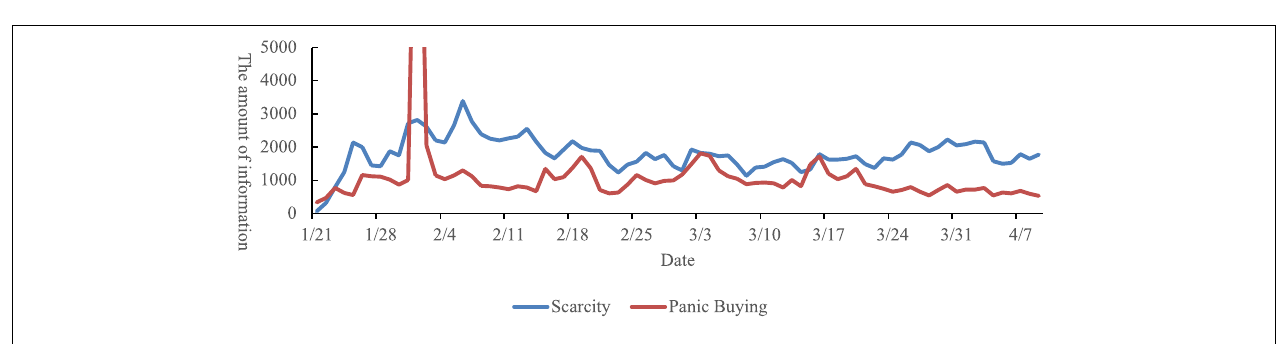
FIGURE 1 | The overall framework.